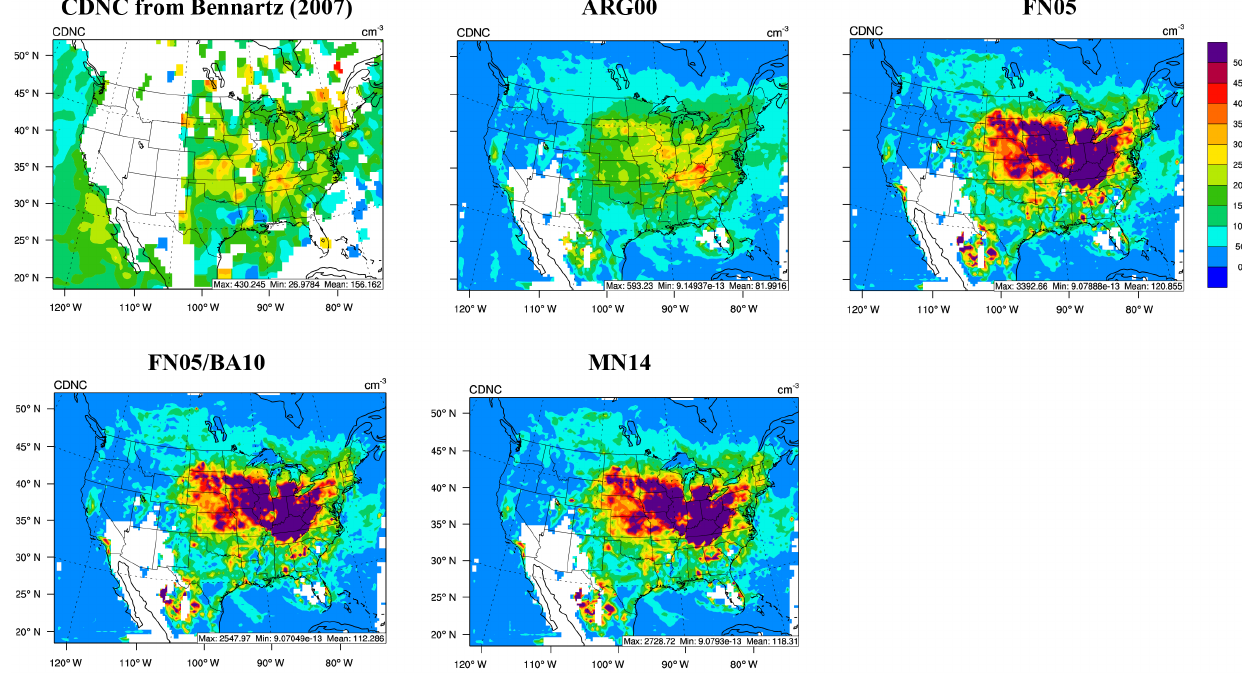
Figure 11. Spatial plots for MODIS-derived CDNC from Bennartz (2007) and simulated in-cloud column CDNC from CB05_25%FF_EM3 ARG00, FN series, and MN14 from May to June 2010.